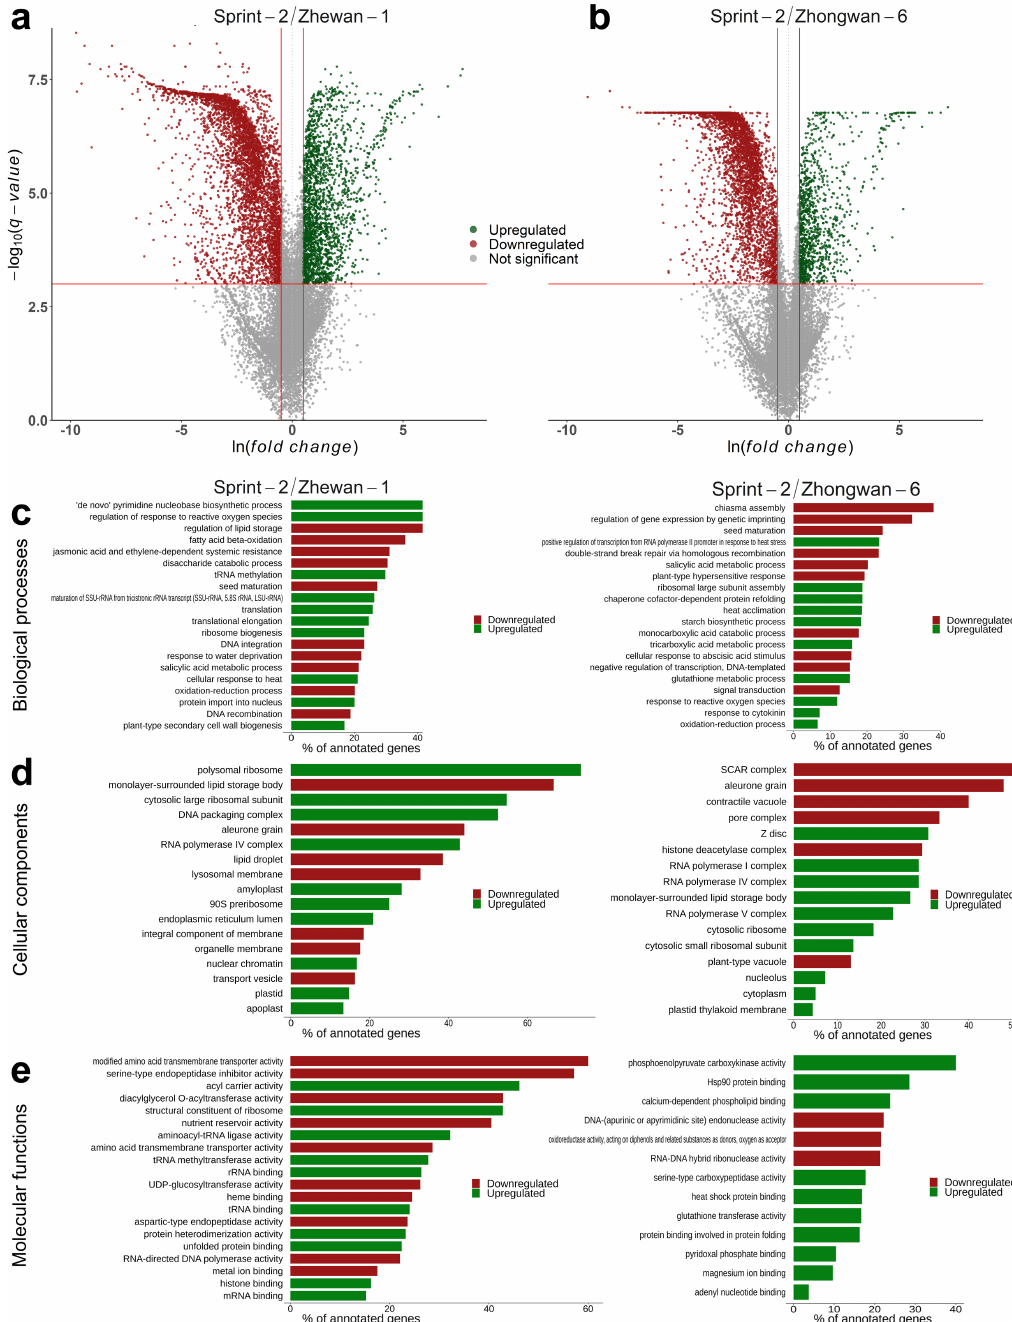
Figure 6. Di ff erential expression in 20 DAP seeds of Zhewan-1 and Zhongwan-6 pea cultivars compared to Sprint-2. ( a , b ) Volcano plots demonstrating di ff erentially expressed transcripts in Zhewan-1 and Zhongwan-6, respectively, compared to Sprint-2. Plotted on the x -axis is the ln fold di ff erence between Sprint-2 and the corresponding cultivar. Plotted on the y -axis is the − log 10 (q-value). Genes whose expression changes are nonsignificant are shown in gray below the red line, while significant di ff erentially expressed genes (FDR < 0.001) are divided into upregulated (green dots) and downregulated (red dots) genes. ( c – e ) Visualization of terms over-represented among di ff erentially expressed genes from Biological Process, Cellular Component, and Molecular Function aspects, respectively. The first ten categories have been chosen per aspect and arranged by the adjusted q-value. Bars are ranked according to the number of transcripts from the respective category being di ff erentially